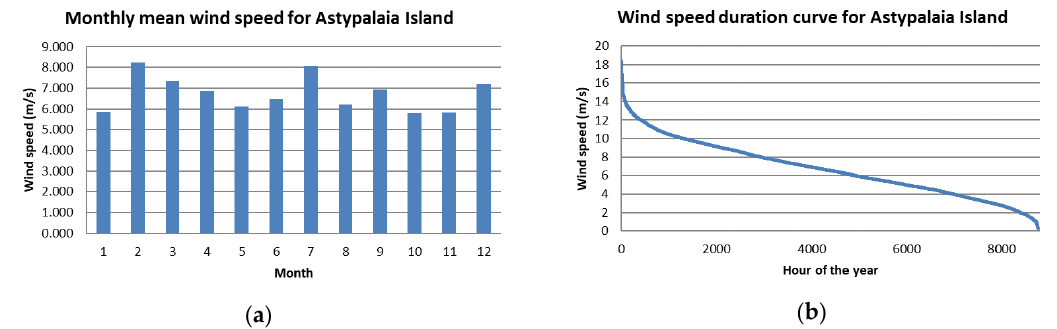
Figure 2. Wind data for a mountainous location in the northwest of Astypalaia (10 m anemometer height with annual mean wind speed of 6.73 m/s): ( a ) monthly mean wind speed; ( b ) wind speed duration curve.